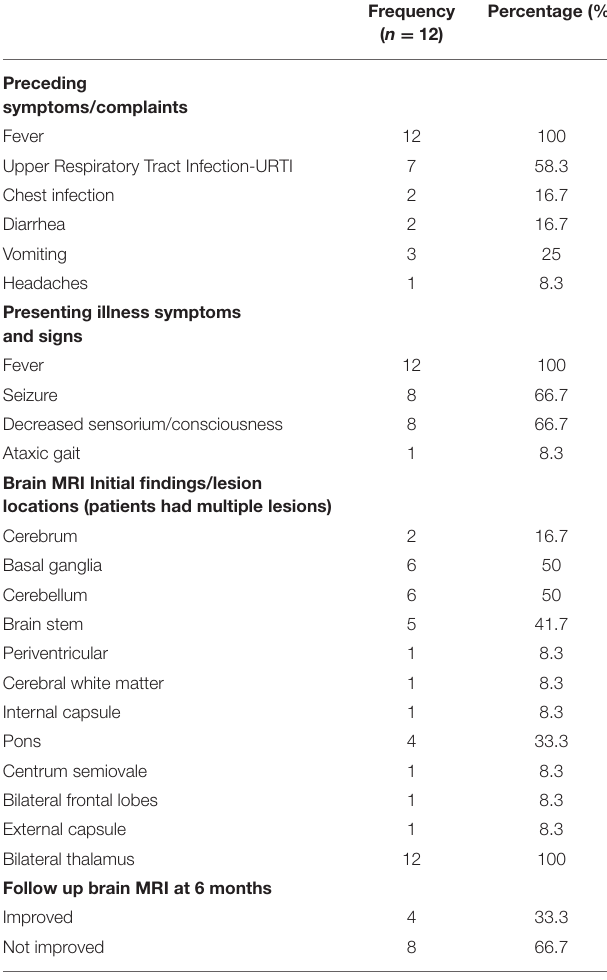
TABLE 2 | Clinical characteristics and radiological features of the